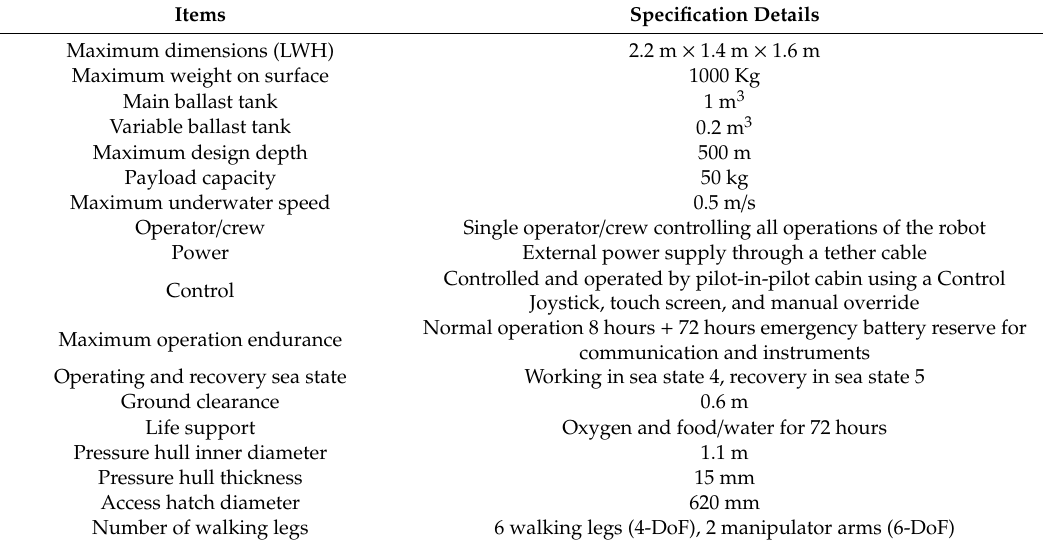
Table 1. Specifications of